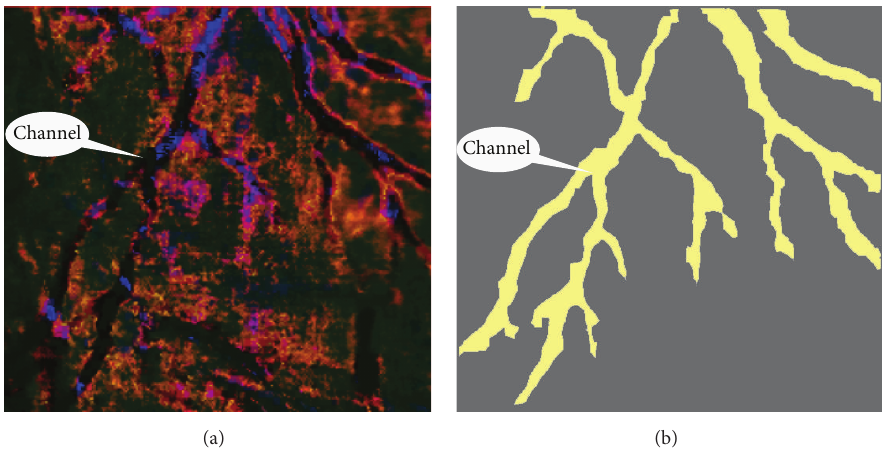
Figure 5: (a) Slice of the color-blended volume; (b) channel geological interpretation.